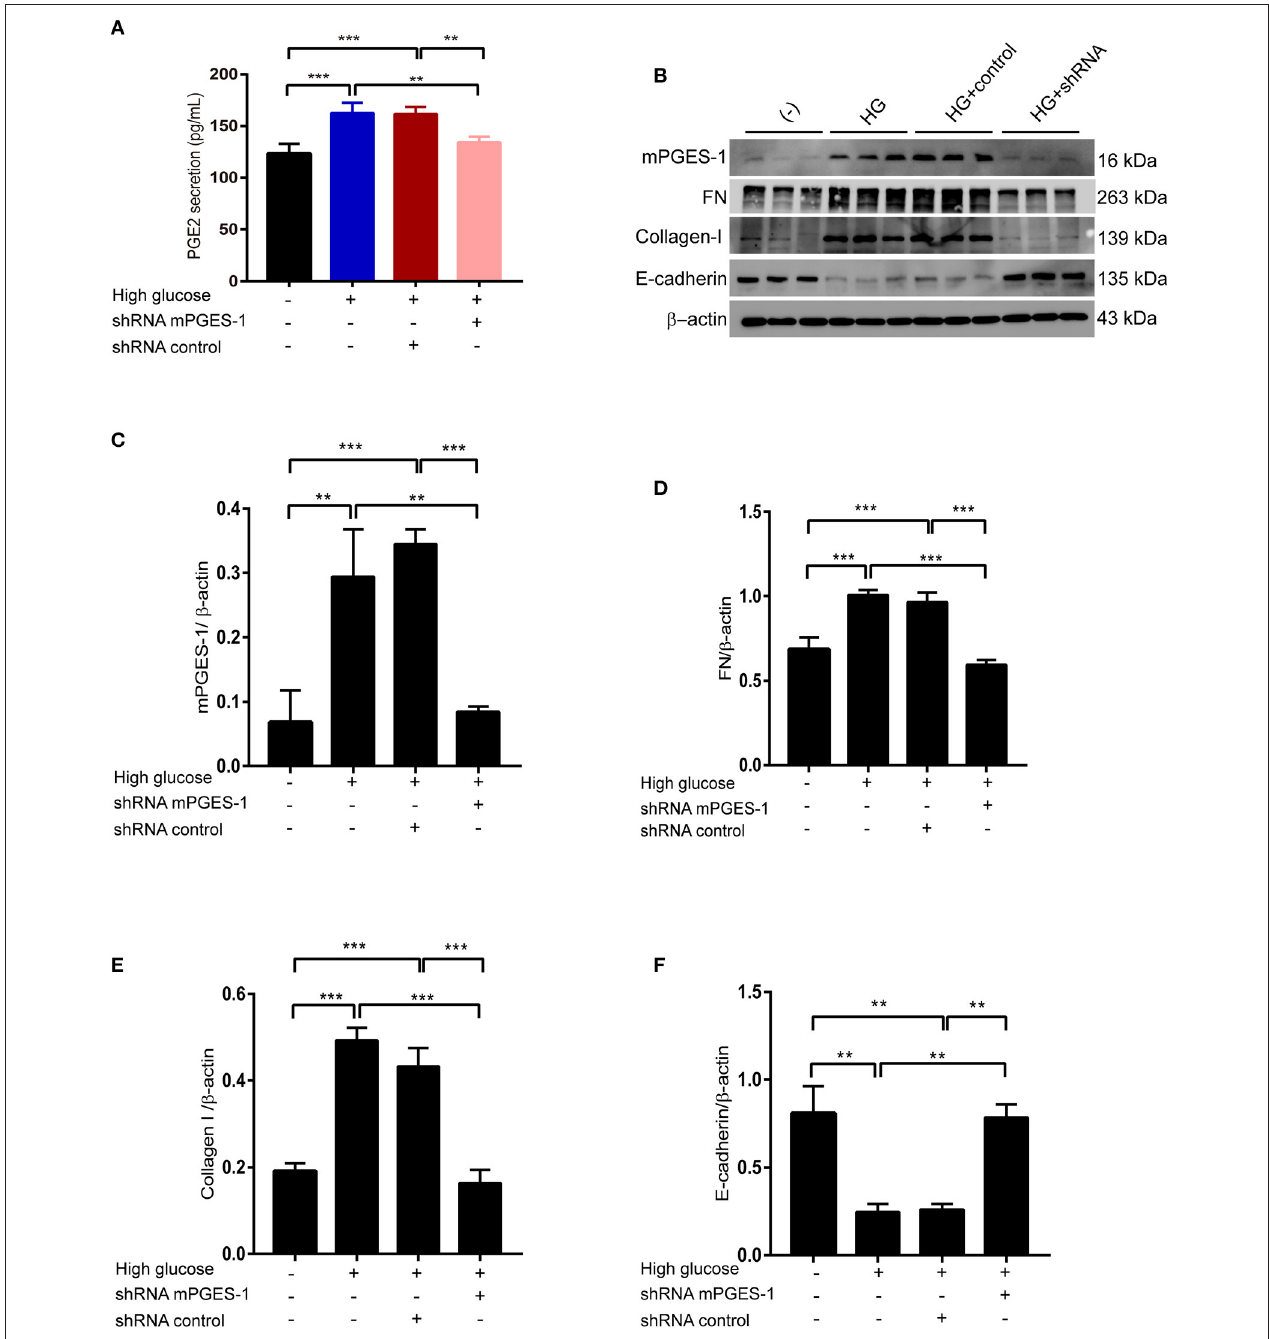
FIGURE 4 | Inhibition of mPGES-1 ameliorates high-glucose-induced synthesis of extracellular matrix proteins in RPMCs. (A) RPMCs were treated with mPGES-1 shRNA plasmid or control shRNA plasmid, followed by incubation with high glucose for 48h. ELISA of PGE2 in cell culture medium in RPMCs treated with normal glucose, high glucose, high glucose plus shRNA control or high glucose plus mPGES-1 shRNA. (B) RPMCs were transfected with the mPGES-1 shRNA plasmid or control shRNA plasmid, followed by incubation with high glucose for 48h. Western blotting confirmed the expression of mPGES-1, FN, Collagen-I, and E-cadherin. Quantitative analyses of mPGES-1, FN, Collagen-I, and E-cadherin were displayed in the (C–F) . The data are represented as the mean ± SEM. ** P < 0.01, *** P <